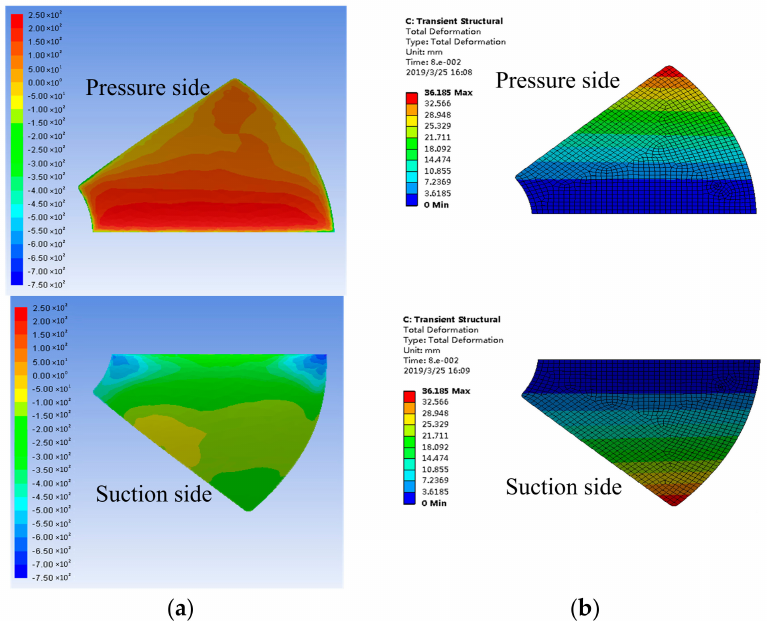
Figure 16. Analysisresultsofnumericalsimulationofflexibleblades: ( a )Pressurecontours;( b